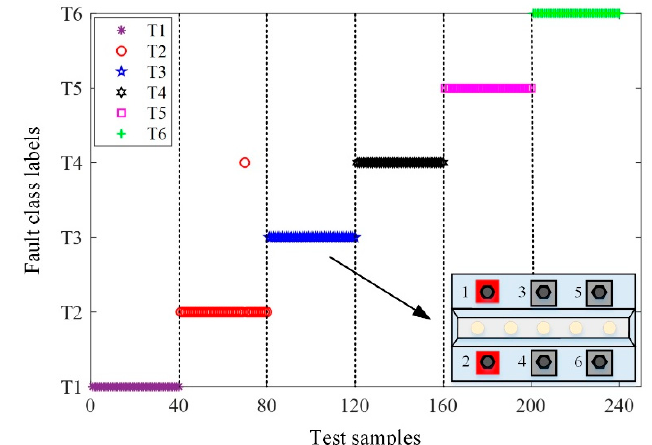
Figure 7. Prediction results on the test set.